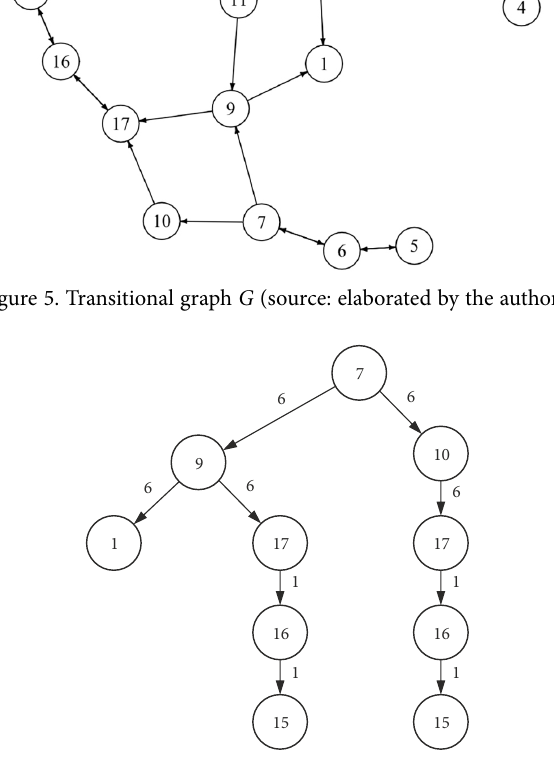
Figure 6. Trend tree (source: elaborated by the